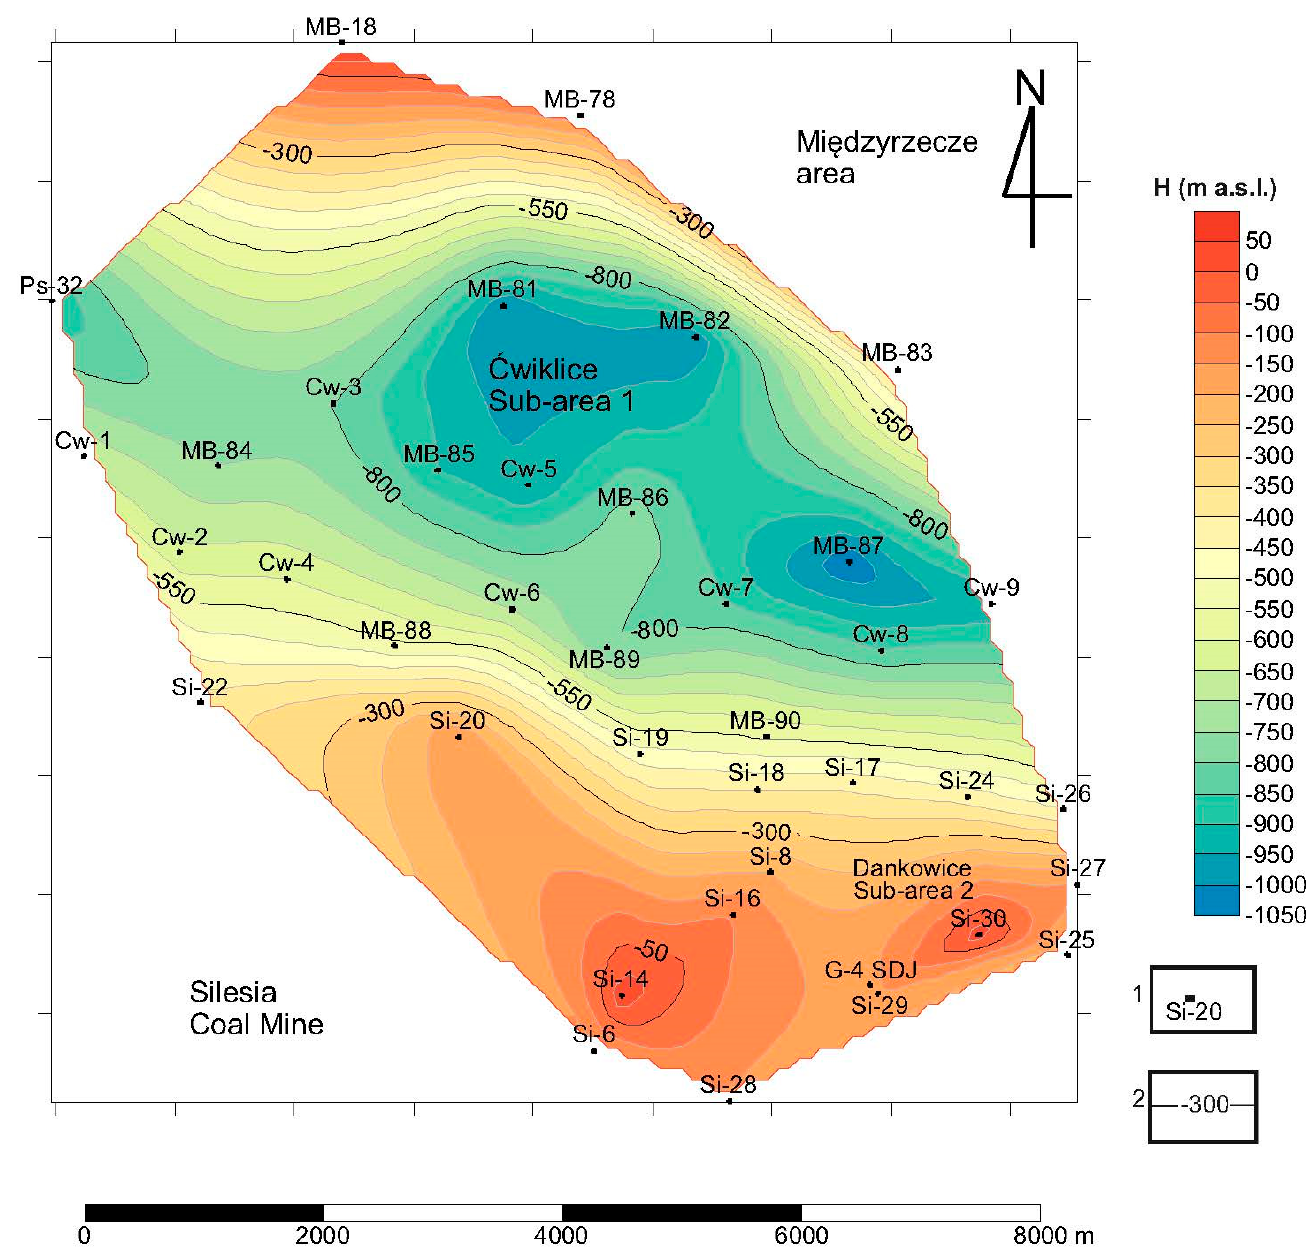
Figure 10. The topography of the top of the Mudstone Series; 1—isoline of the top (H) of the Mudstone Series (m above sea level). Other explanations as on Figures 10–12.